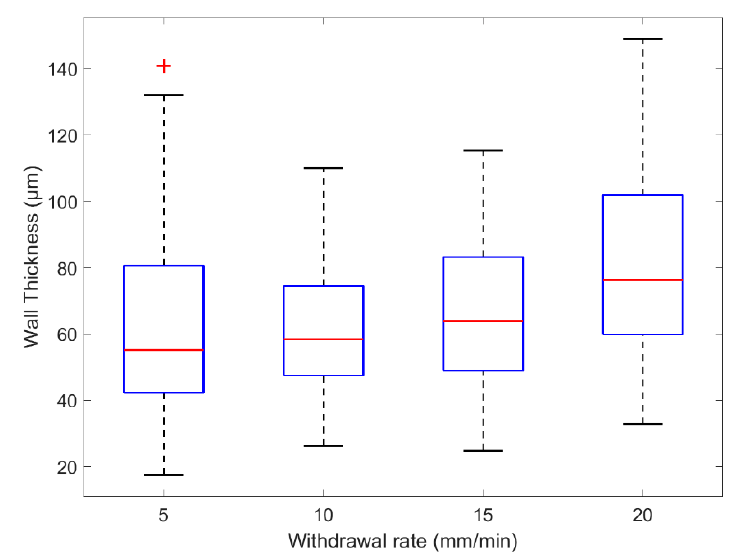
Figure 5. Box plot of wall thicknesses measured from custom vessels withdrawn at several rates.